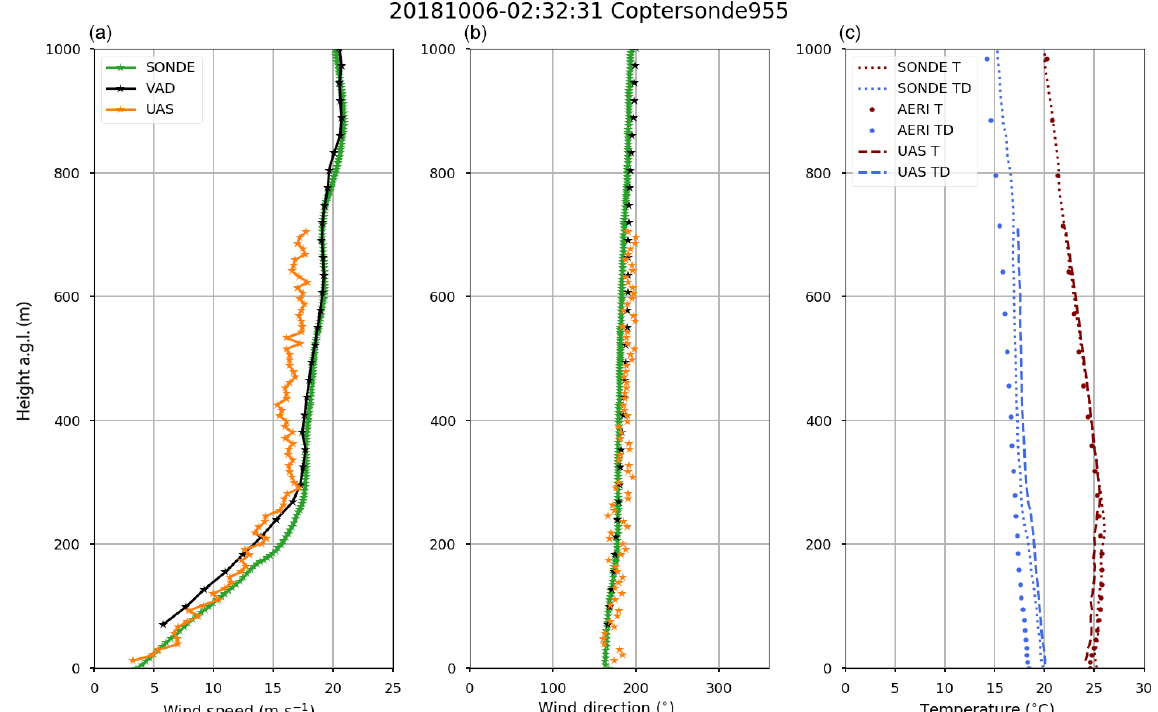
Figure 14. Same as Fig. 12 but for 6 October 2018 at KAEFS during Flux